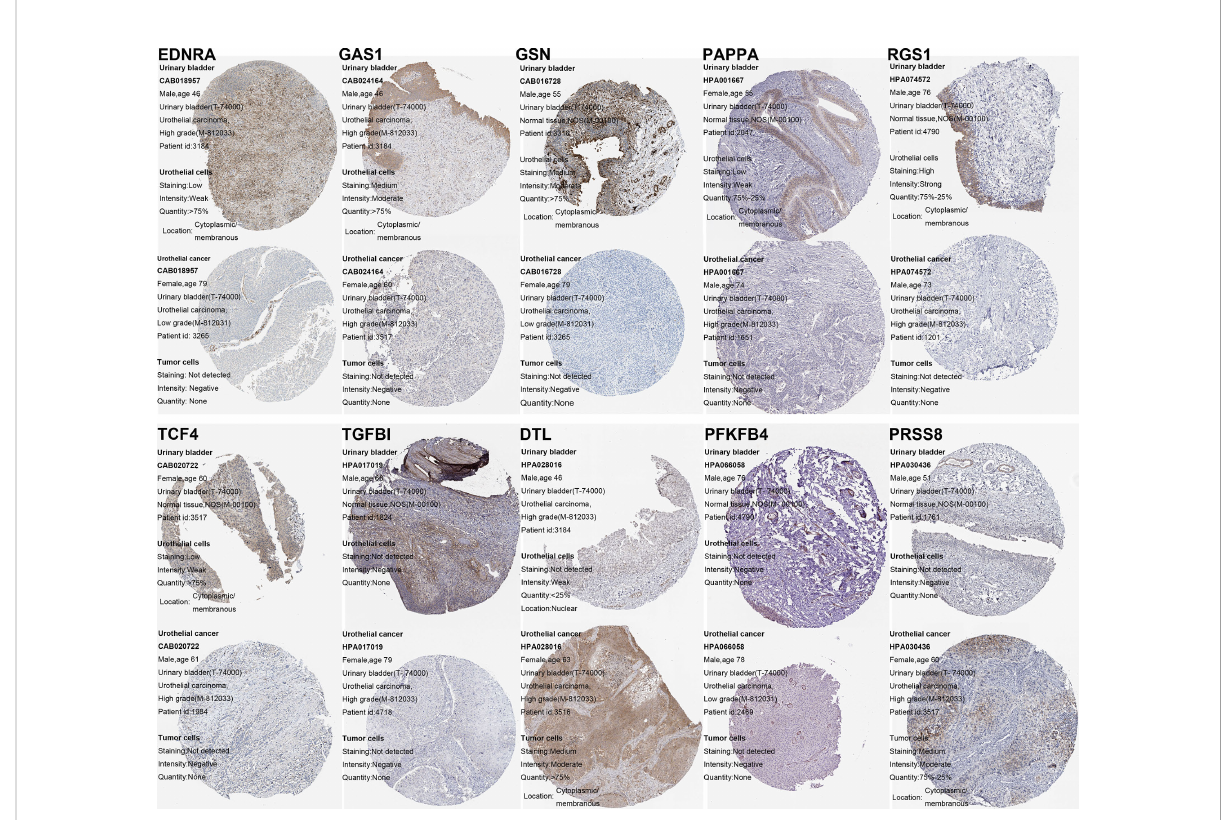
FIGURE 4 Veri fi cation of the ceRNA-associated modeled genes expression in BCa and normal bladder tissue using the HPA